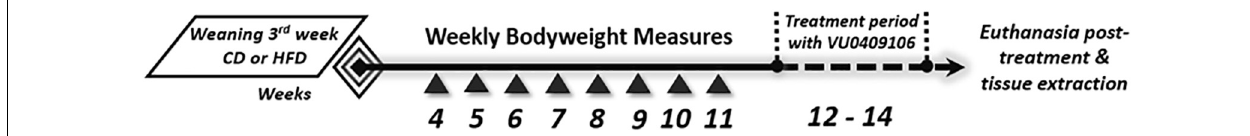
FIGURE 1 | Scheme of diet-induced obesity (DIO) and chronic drug treatment. Three-week-old C57BL/6 mice were divided into control diet group (CD) and high-fat diet group (HFD). Animals were fed ad libitum throughout the experiment. At the 12th and 14th day, daily body weight and food intake were assessed for 14 days. In the last day of treatment, mice were submitted to behavioral experiments and afterward to biochemical